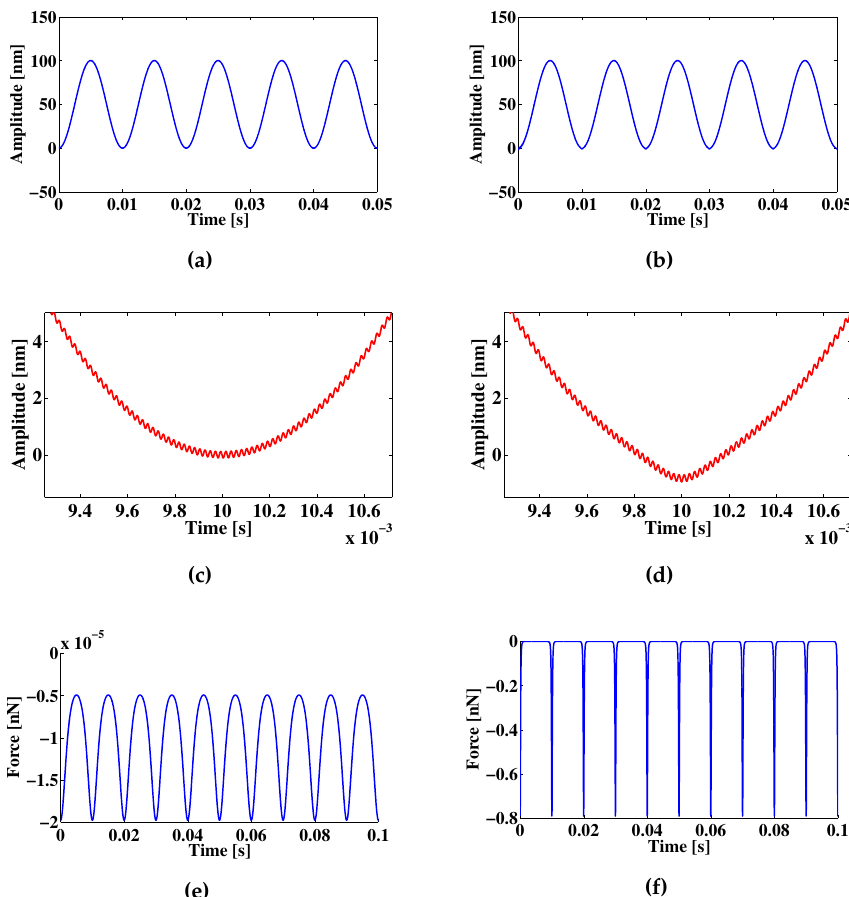
Figure 7. Example of a simulated cantilever tip behavior due to a harmonic motion. ( a , b ) Amplitude representation of a harmonic displacement with the tip placed for d z 1 and d z 2 respectively; ( c , d ) Zoom of the displacement amplitude around the region where the tip is closer to the sample; a deformation of the harmonic motion increases as the minimum tip to sample distance is reduced; ( e , f ) Corresponding force effect for d z 1 and d z 2 .